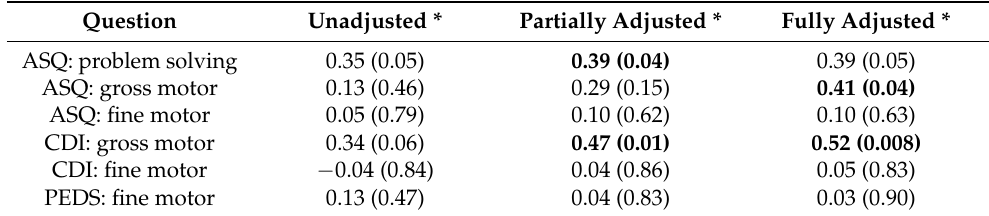
Table 3. Correlation between breastfeeding category and questionnaire score for 33 participants with breastfeeding and outcomes